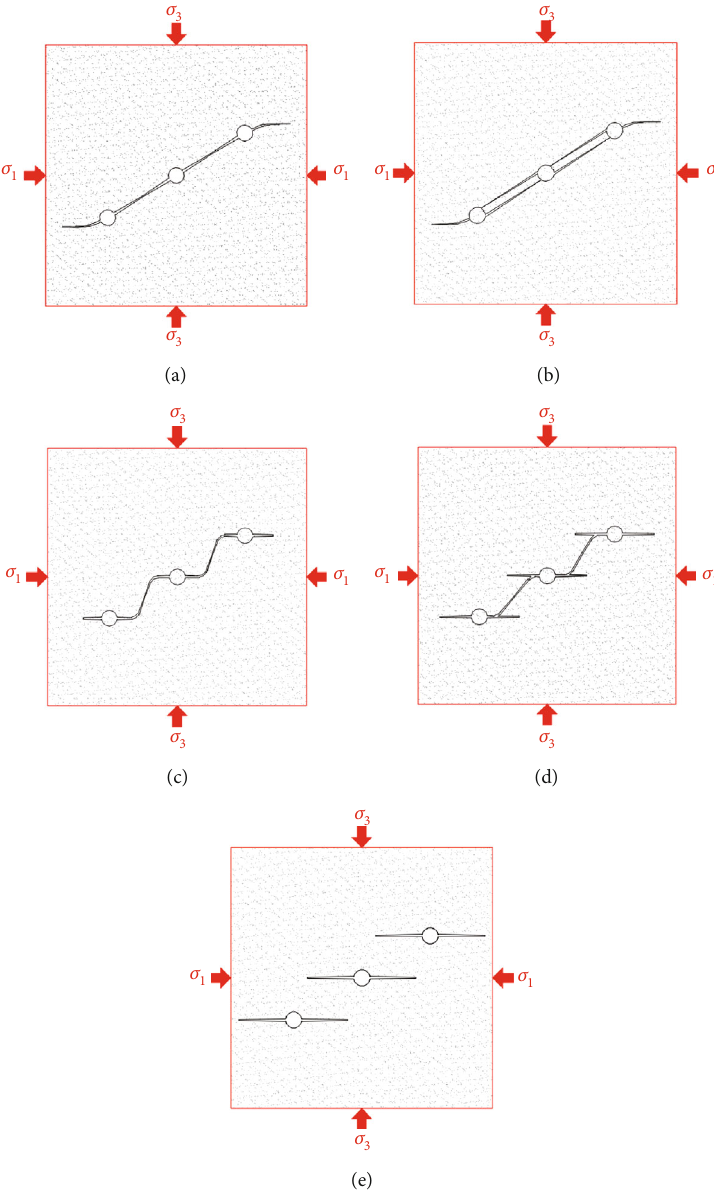
Figure 17: Dense linear multihole directional hydraulic fracture propagation